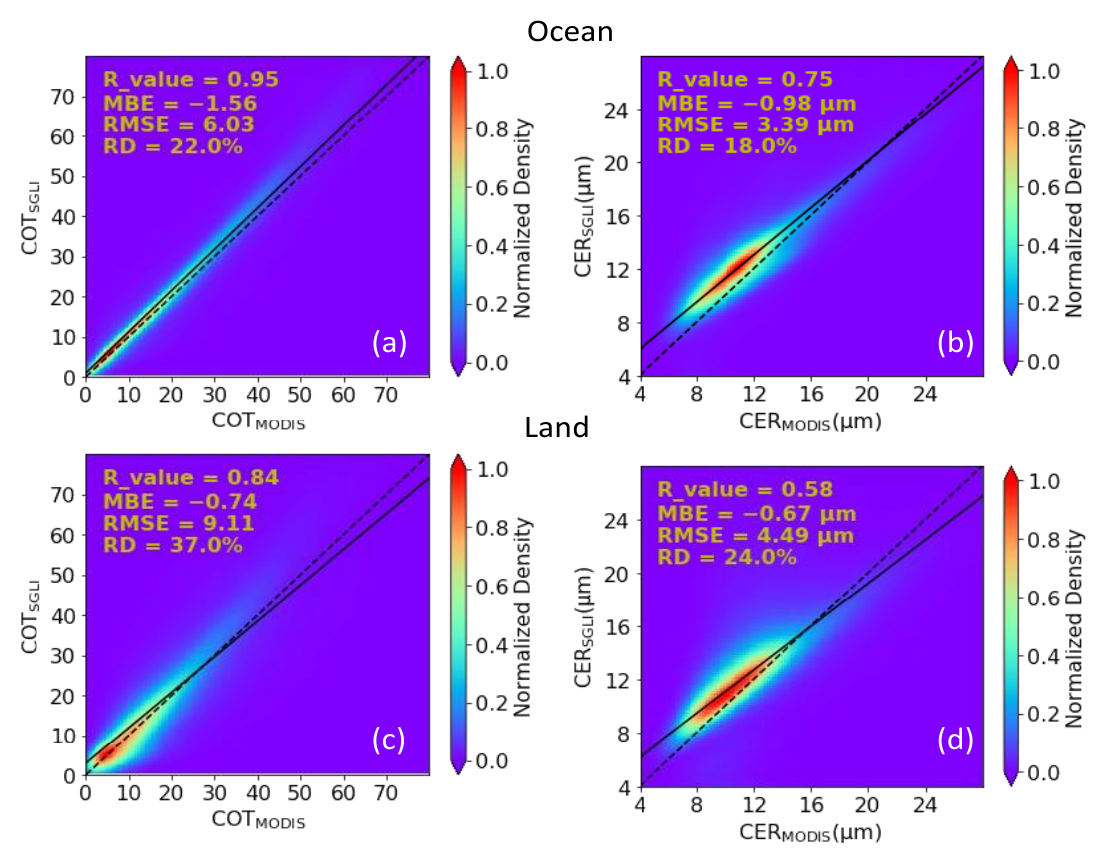
Figure 1 . Comparison between MODIS and SGLI for ( a ) COT over ocean, ( b ) CER over ocean, ( c ) COT over land, and ( d ) CER over land for water cloud pixels.